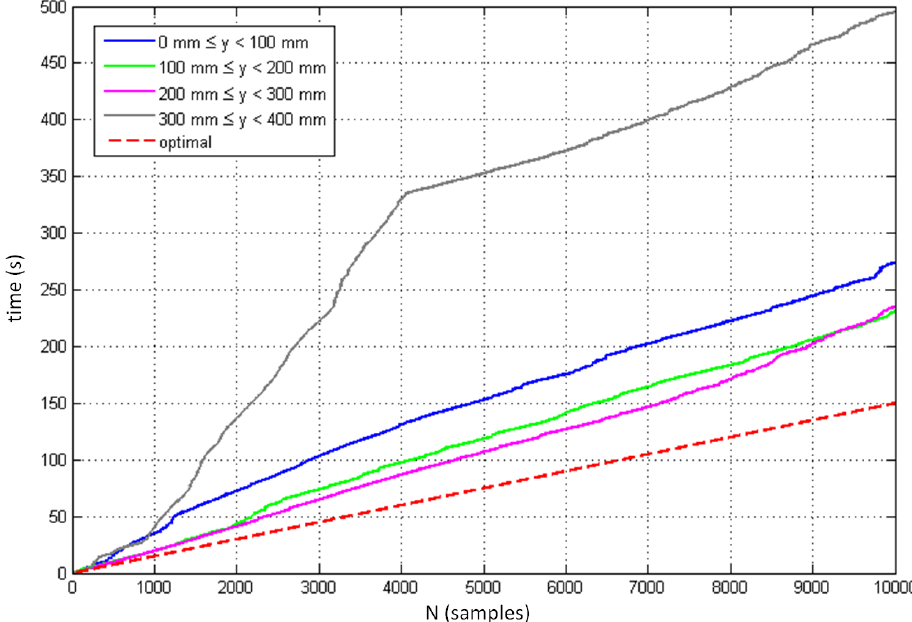
Figure 13. The progress of the measurements in the dynamic scenario (the total time required to collect the initial 10,000 samples in different height